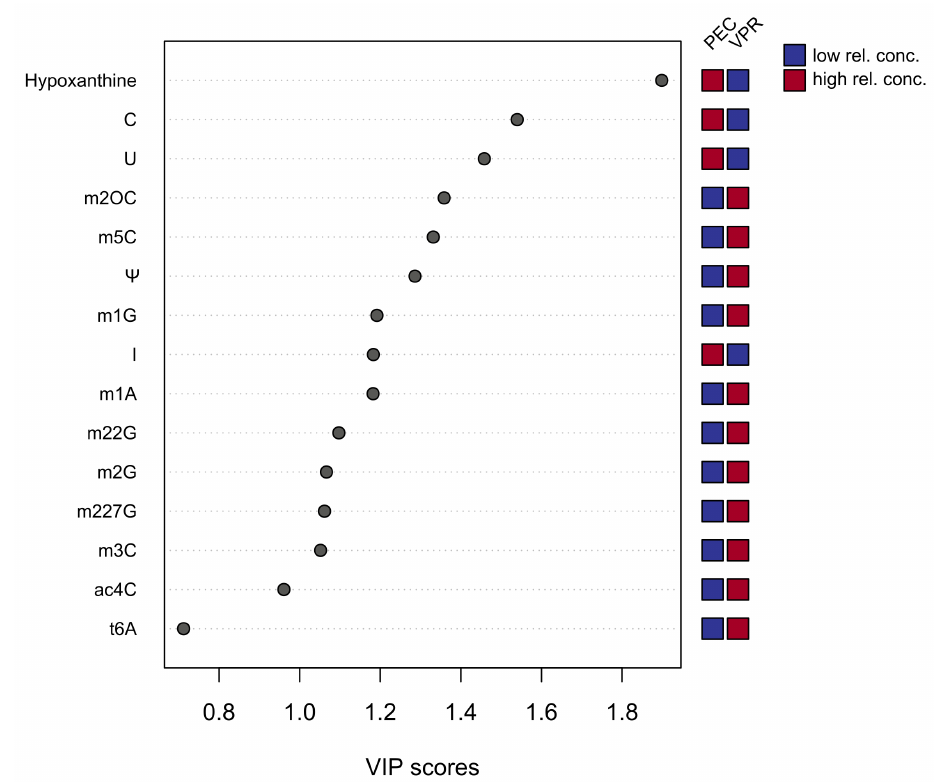
Figure 3. Most significant features of metabolites based on PLSDA-VIP score of component 1. Red and blue boxes indicate the relative concentrations of the respective nucleoside in each group of the study. (PEC = proximal tubular epithelial cells; VPR = triple knockout for Vhl , Trp53 and Rb1 ). Nucleosides such as m2OC, m5C, m1G, m1A, m22G, m2G, m3C, Ψ and m227G have high VIP scores and therefore are the most contributory variables in the class discrimination of the PLSDA model, making them the most relevant